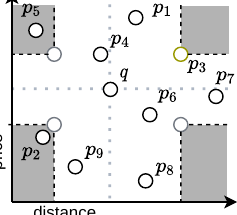
Figure 3. Geometric interpretation of Lemma 3 on our running example with o = p 3 . By mirroring p 3 across q along the coordinate axis (dotted lines), we obtain the grayish-colored nodes. From each grayish-colored node, we spawn a gray-shaded region in which we know that p 3 dominates all points contained in that region. In this example, we obtain that p 3 ≺ q p 2 and p 3 ≺ q p 5 . Lemma 4. Both the siblings of B q and the descendants of B q ’s ancestors with depth at least (cid:0) (cid:1) − B q n + 1 can contain skyline depth